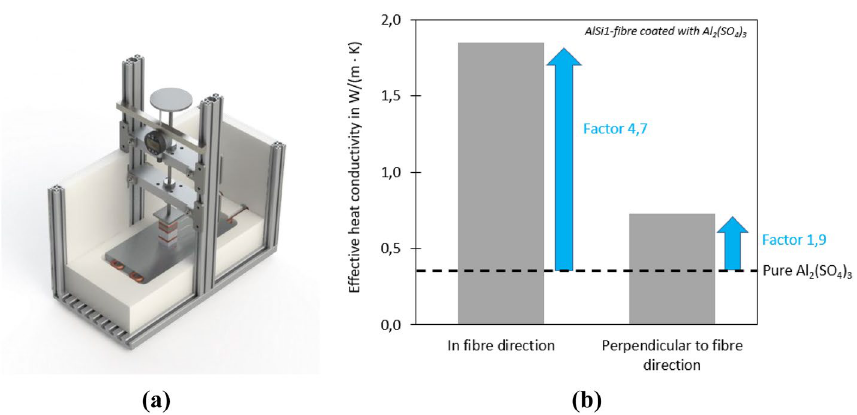
Figure 15. Determination of the effective heat conductivity of aluminium fibre structure coated with Al 2 (SO 4 ) 3 . ( a ) experimental setup plate apparatus and ( b ) measurement results compared to pure Al 2 (SO 4 ) 3